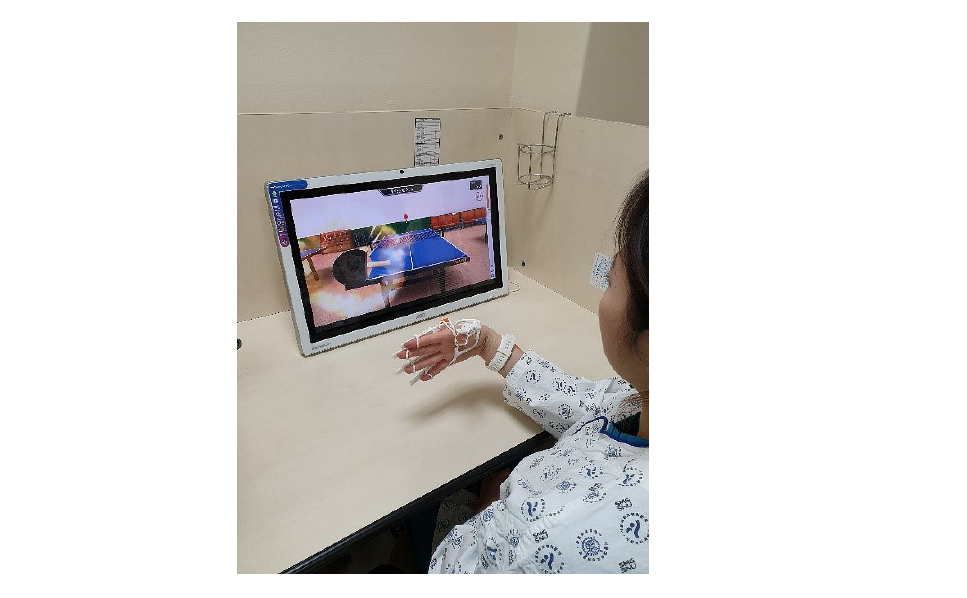
Figure A1. Wearable device (RAPAEL Smart Gloves).